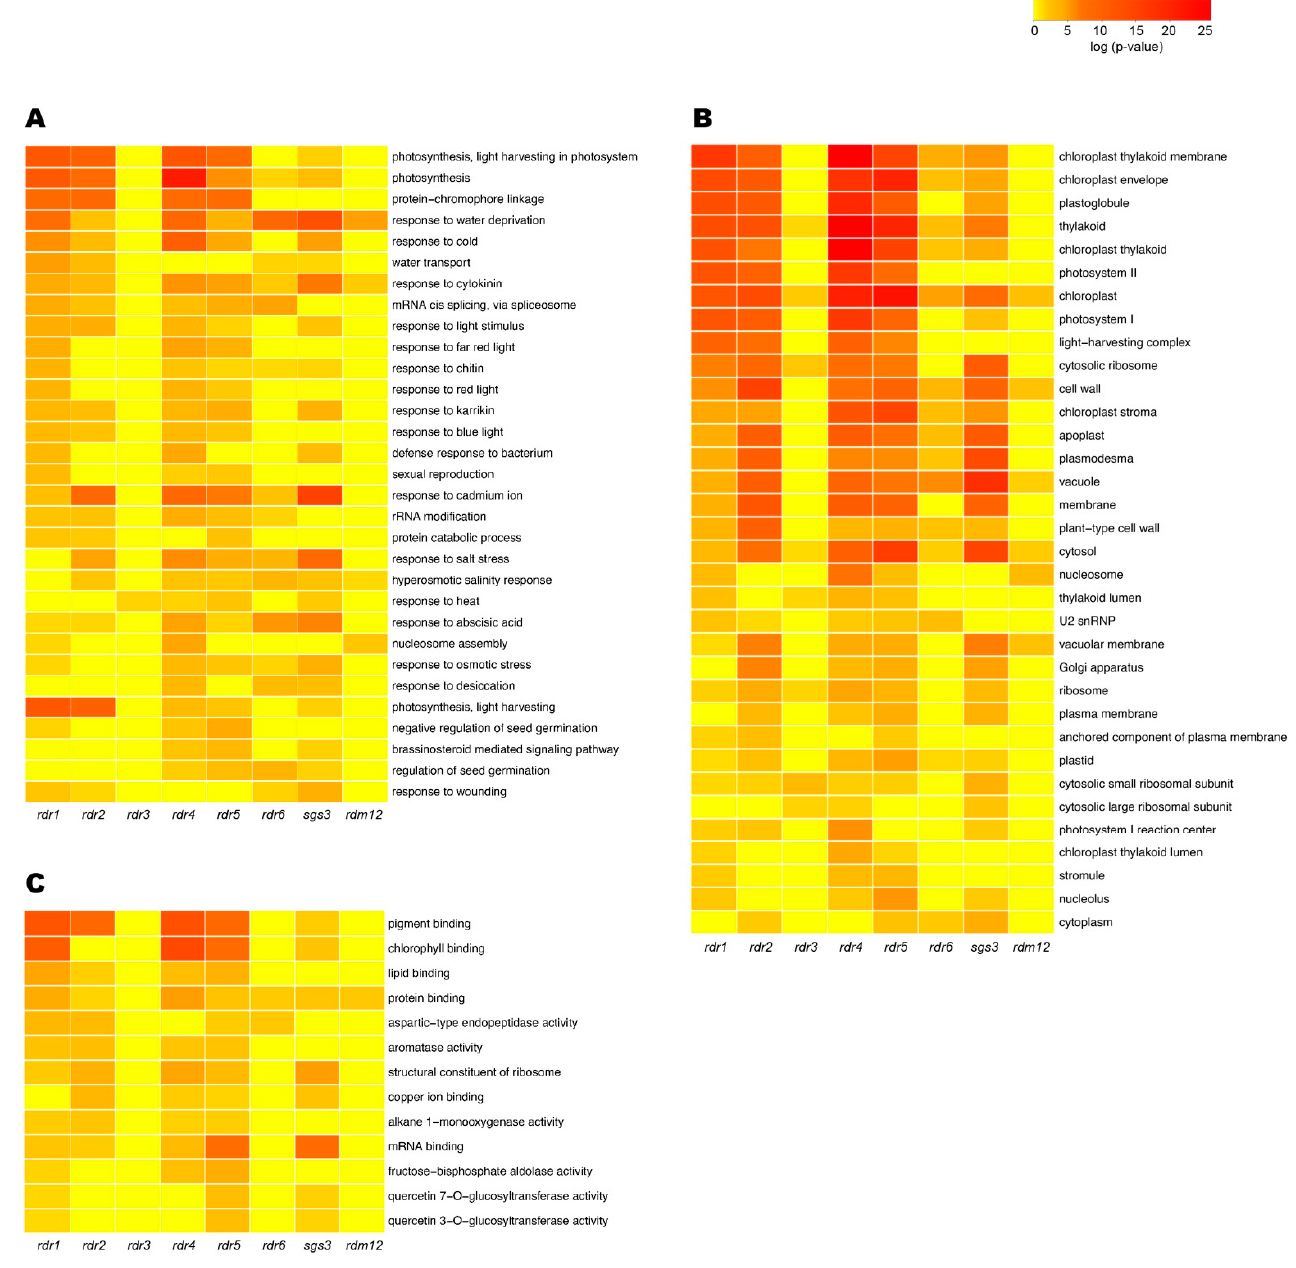
Figure 2. Heatmap of Gene Ontology (GO) enrichment terms for significantly more abundant transcripts in rdr1–6 , sgs3 , and rdm12 mutants as compared to Col-0. The significantly more abundant transcripts ( p -value < 0.05; edgeR) are plotted on the heatmaps and clustered by GO terms ( p -value < 0.05; DAVID). Each column indicates a mutant genotype (as specified), each row presents a GO term (as specified), colors correspond to the log 10 of p -value associated with each GO term, with red color showing the highest levels of significant enrichment within that GO category. ( A ) GO terms for biological processes. ( B ) GO terms for cell components. ( C ) GO terms for molecular function.